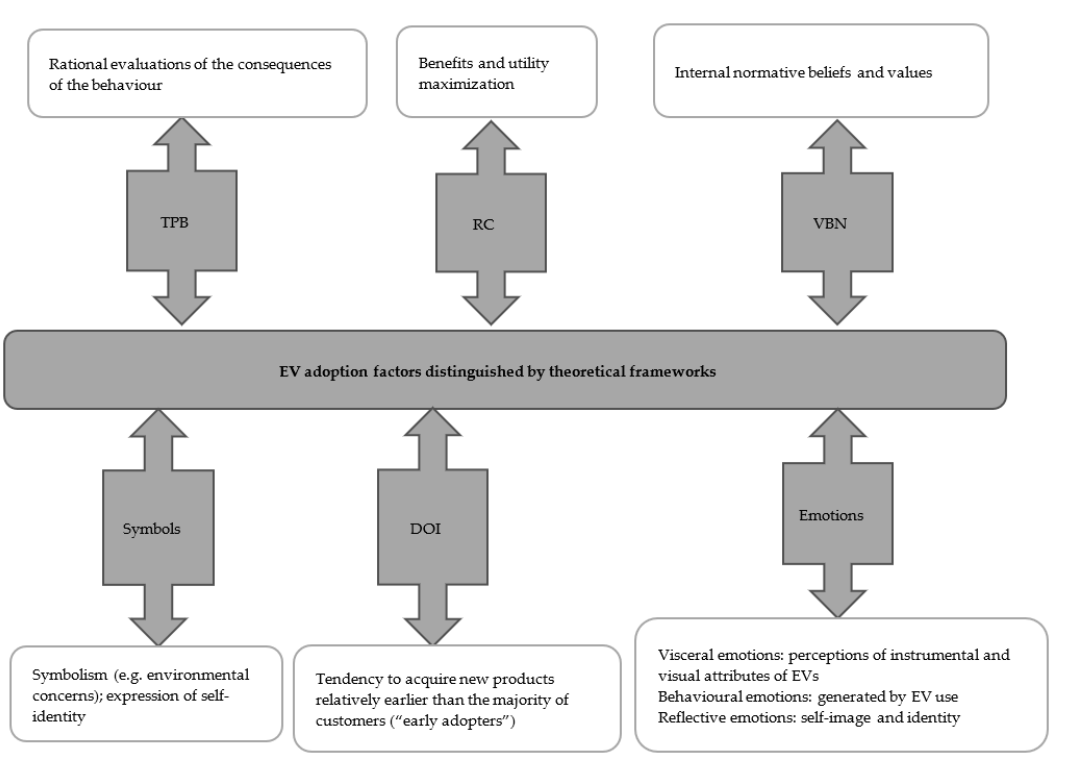
Figure 1. Basis of consumers’ behaviour according to various theoretical frameworks. Source : own study, based on [26].